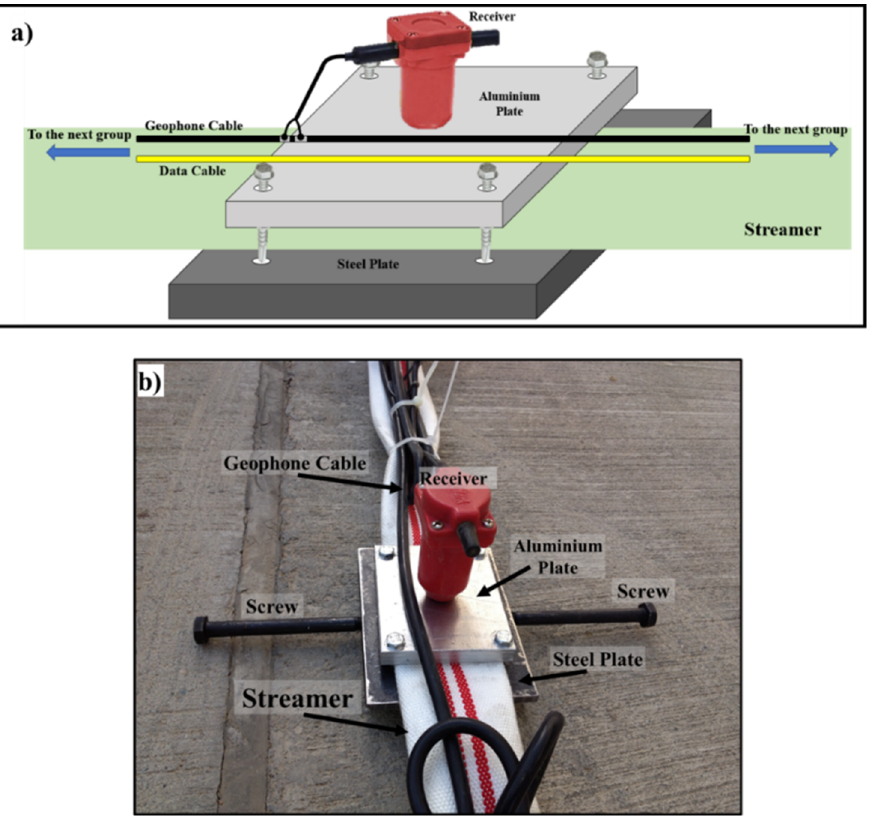
Figure 1. ( a ) The design of the land-streamer used in this work. It shows the receiver, the plates, the streamer, and the cables connected to the recording system. ( b ) An actual photo of the used land-streamer. The two screws shown at the sides of the plate are used to increase the stability of the land-streamer on irregular